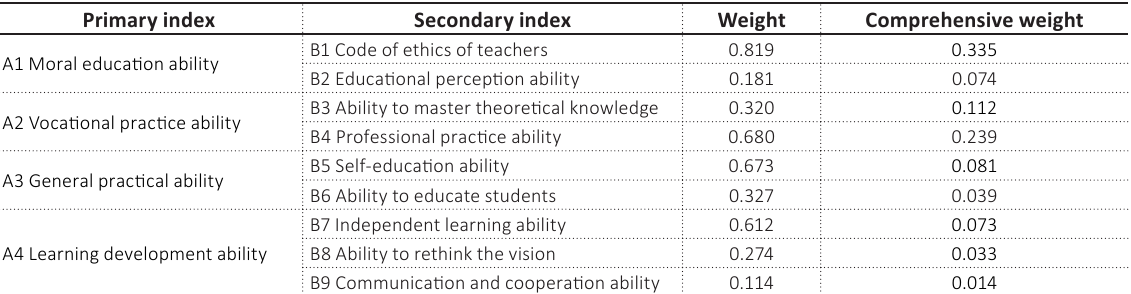
Table 6. Comprehensive weight of secondary-level